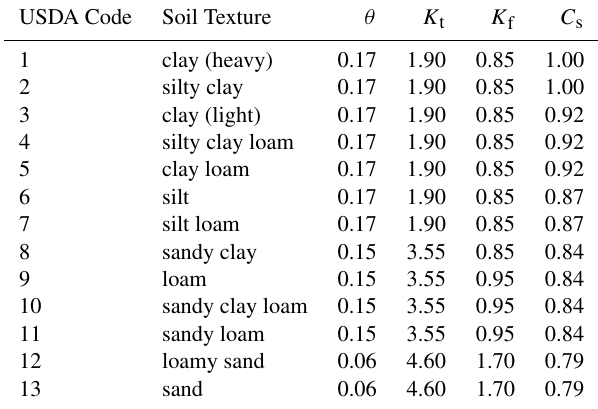
Table 3. Parameters of thermal conductivity in the thawed/frozen state. The UADS Code came from soil texture classification of United States Department of Agriculture (USDA). The Qinghai- Tibet Plateau does not have the 1 and 8 of soil